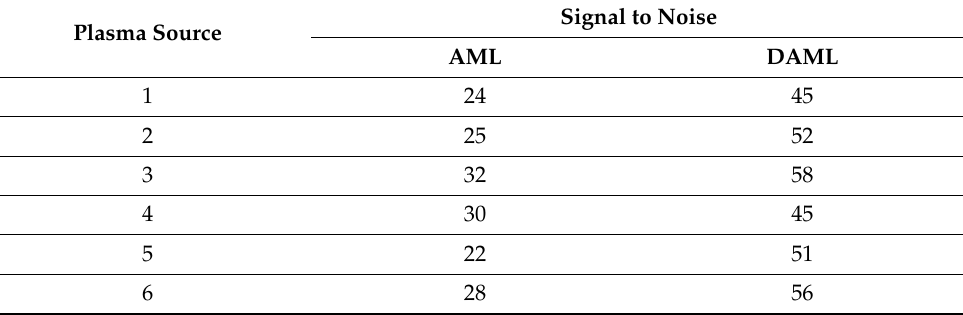
Table A3. Signal to noise values in human blood plasma spiked with AML and DAML at LLOQ 1.0 ng/mL.